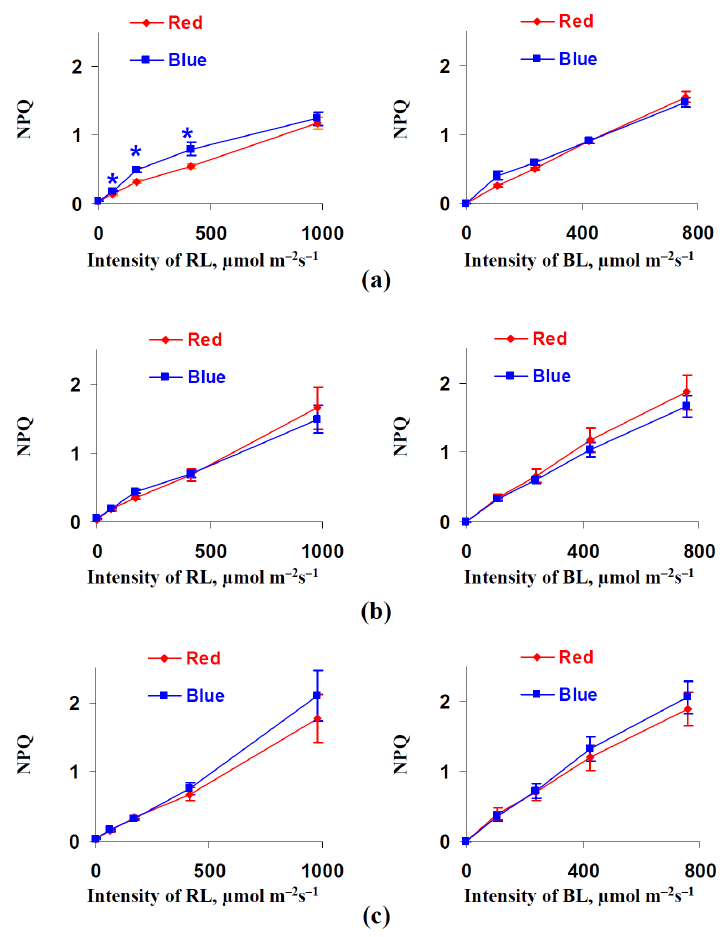
Figure 5. Dependences of the non-photochemical chlorophyll fluorescence quenching (NPQ) on the red actinic light (RL) intensity (left panels) and blue actinic light (BL) (right panels) after 18 ( a ), 25 ( b ), and 32 ( c ) days of lettuce cultivation under the red (marked as “Red”) and blue (marked as “Blue”) illumination variants (see Figure 1) ( n = 5–7). * differences between plants cultivated under the red and blue illumination variants were significant ( p < 0.05).